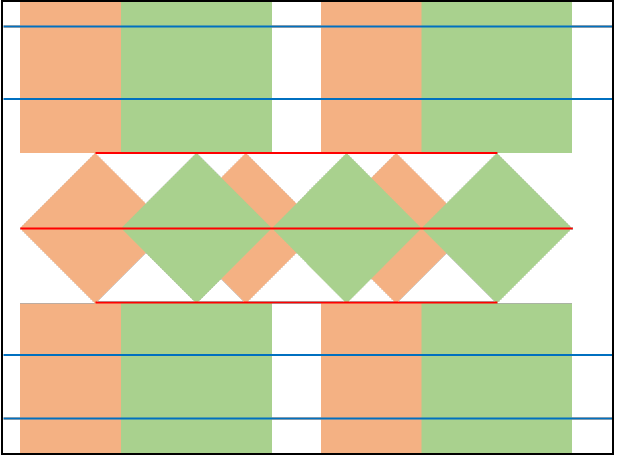
Figure 11. Two rectified images, epipolar line, and diamond segments.